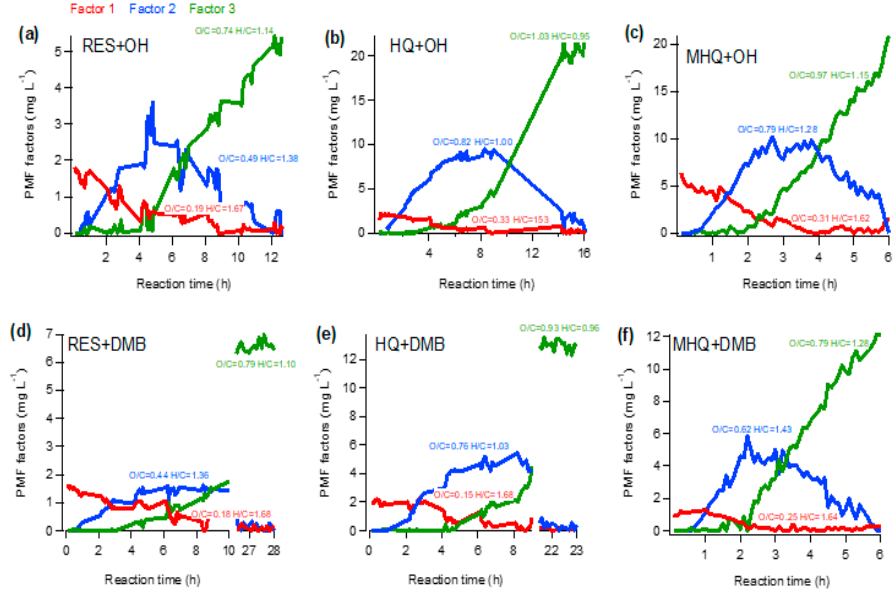
Figure 6. Temporal variations of the three factors from the positive matrix factorization (PMF) analyses of aqueous-phase products in the oxidation of ( a , d ) MHQ, ( b , e ) RES, and ( c , f ) HQ. The O/C and H/C of each factor are also shown.